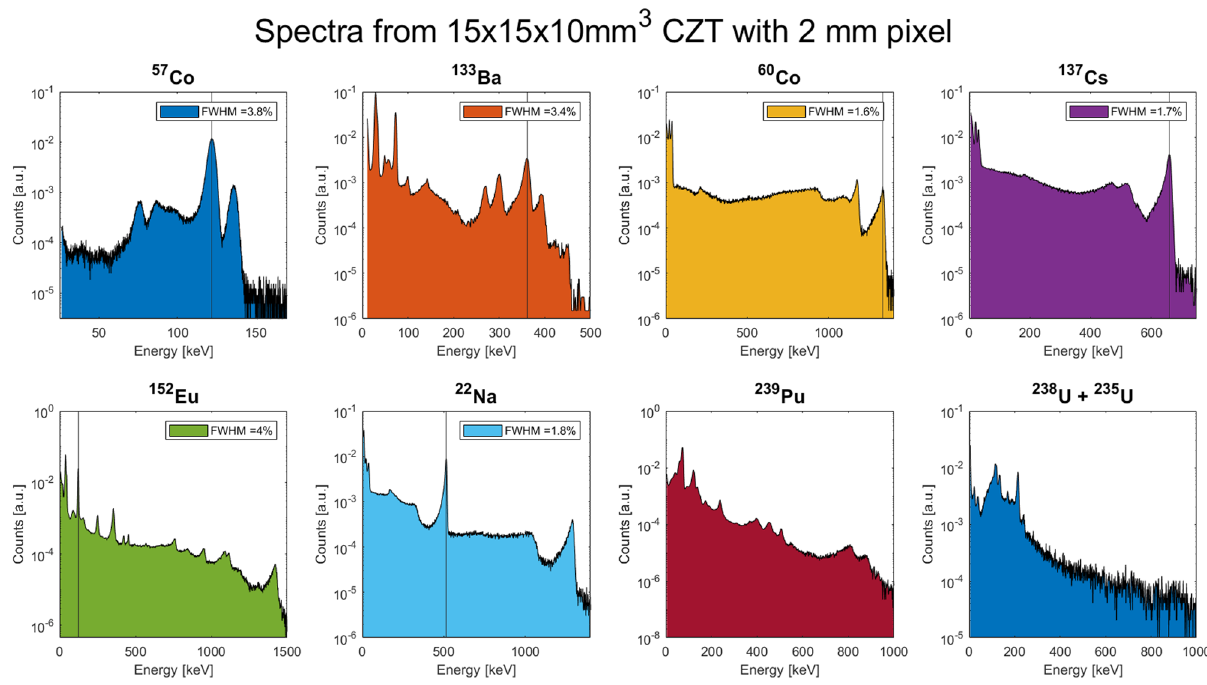
Figure 13. V22 2000B detector response to several nuclear sources. The legend in the subplots reports the FWHM of the photopeak indicated by the vertical line. Measurements were carried out at 20 °C.